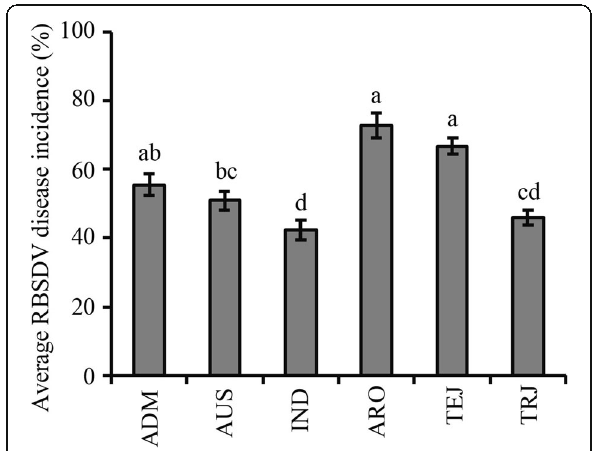
Fig. 3 Multi-comparison of RBSDV disease incidences of different sub-populations in the RDP1. Letters above columns indicate different statistical groups on 5% statistically significant difference. ADM, Admixture; AUS, aus ; IND, indica ; ARO, aromatic ; TEJ, temperate japonica ; TRJ, tropical